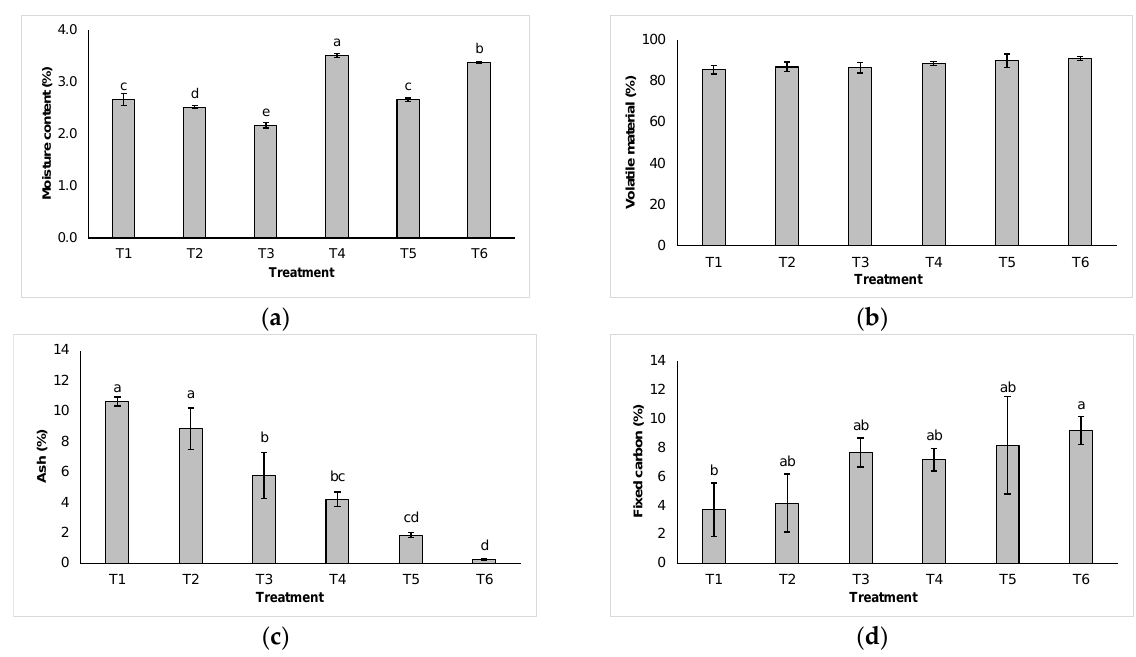
Figure 2. Proximate analysis of pellets produced from mixtures of Agave durangensis and Pine spp. sawdust: ( a ) moisture content (%); ( b ) volatile material; ( c ) ash (%), and ( d ) fixed carbon (%). Different letters indicate statistically significant differences among treatments by the Tukey or Kruskal–Wallis tests ( p < 0.05).